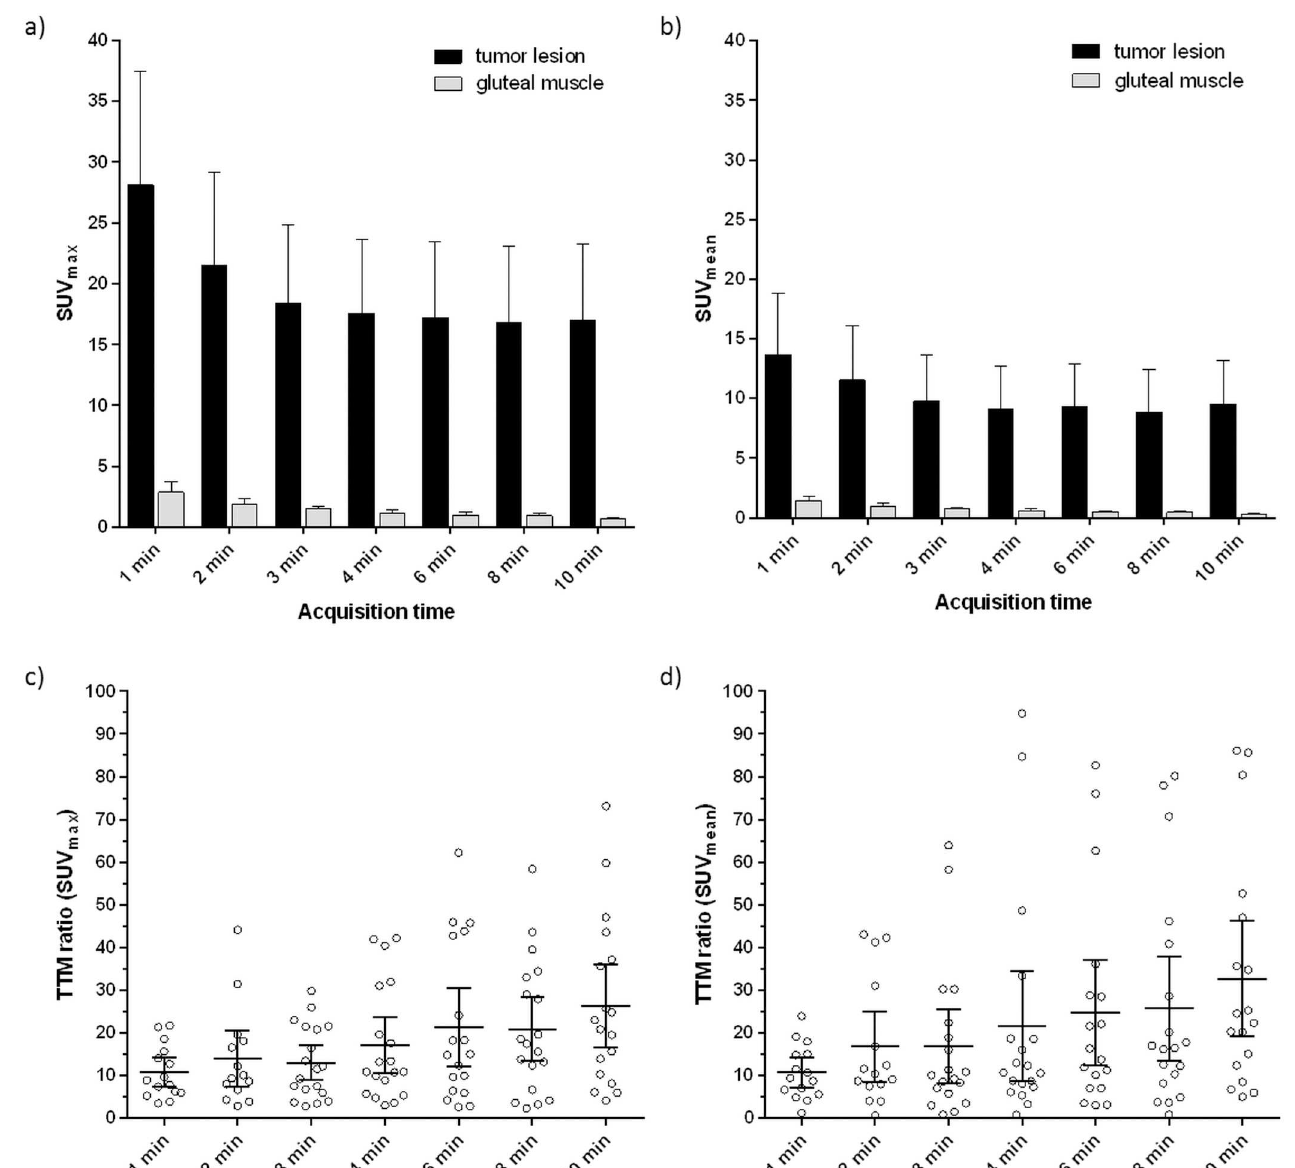
Fig 4. SUV max (a)) and SUV mean (b)) of tumor lesions and gluteal muscles at different PET acquisition times obtainedwith of 68 Ga- HBED-CC-PSMA PET/MRI. SUV max and SUV mean show a decreasingtrend with increasingacquisition times, but remain stable at acquisition times of 4 min and later. Tumor-to-muscle (TTM) ratios at different acquisition time points based on SUV max (c)) and SUV mean (d)) measurements. Data are represented in mean ± 95% confidence